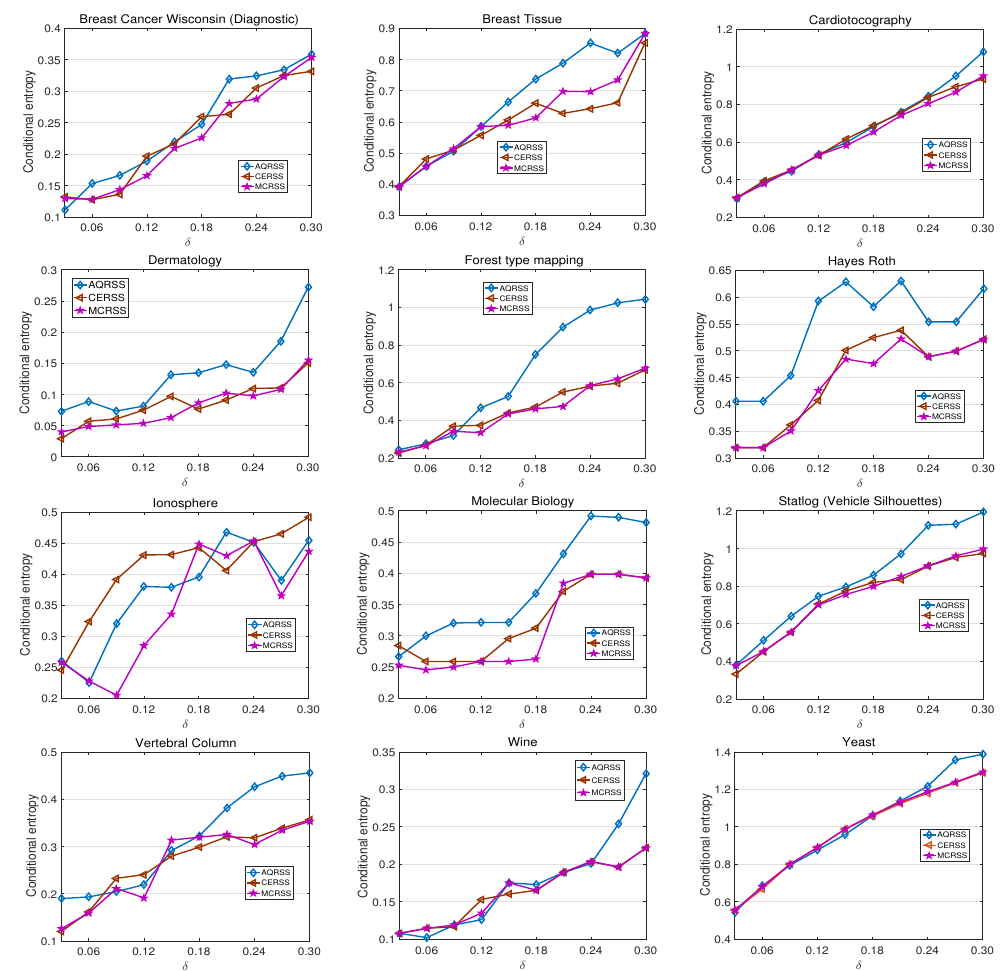
Figure 2. Comparisons of conditional